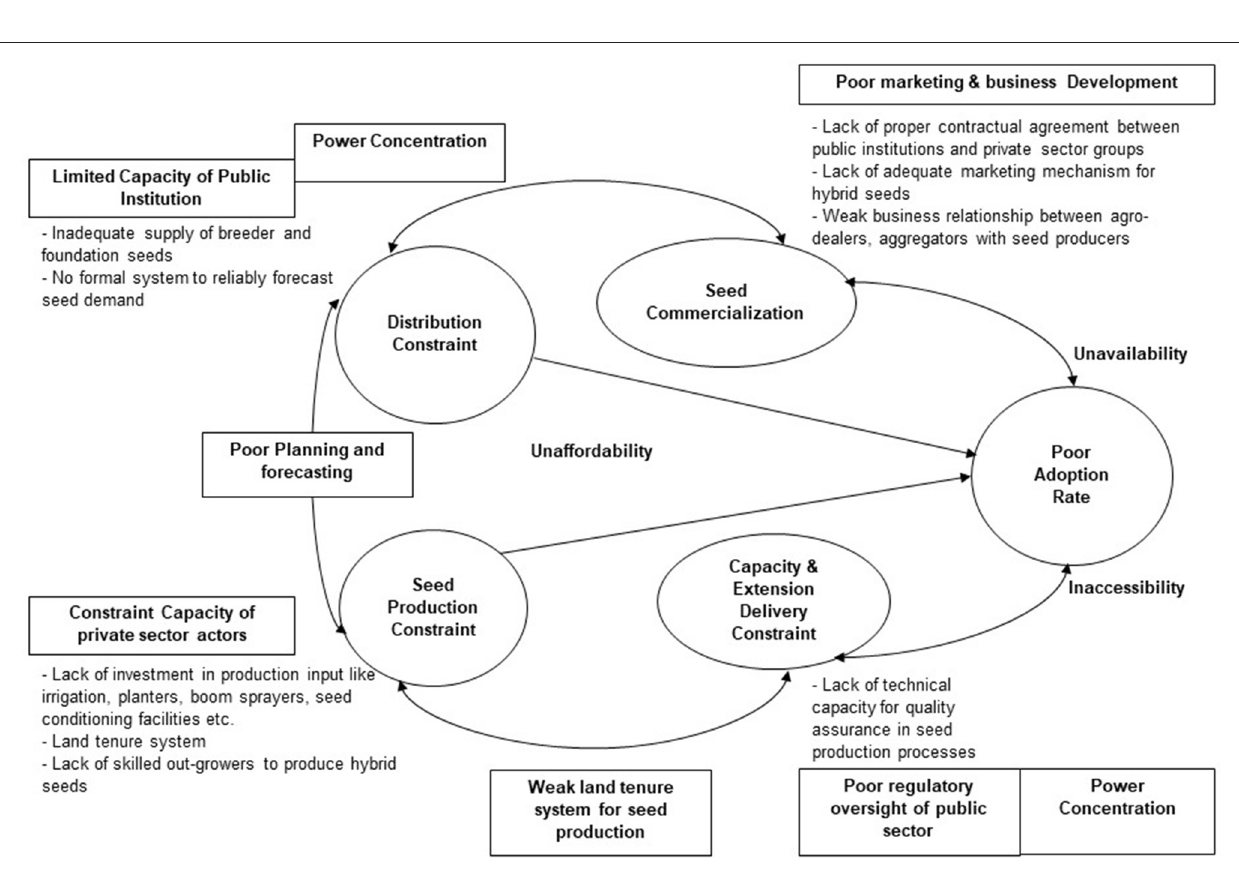
FIGURE 5 | Maize seed value chain